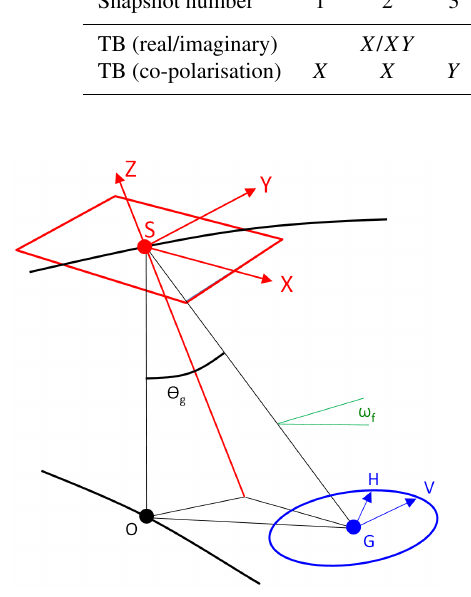
Figure 4. Transformation from antenna (S) to ground reference frame (G). ω f is the Faraday rotation angle and (cid:50) g is the geometric rotation angle (adapted from SMOS L2